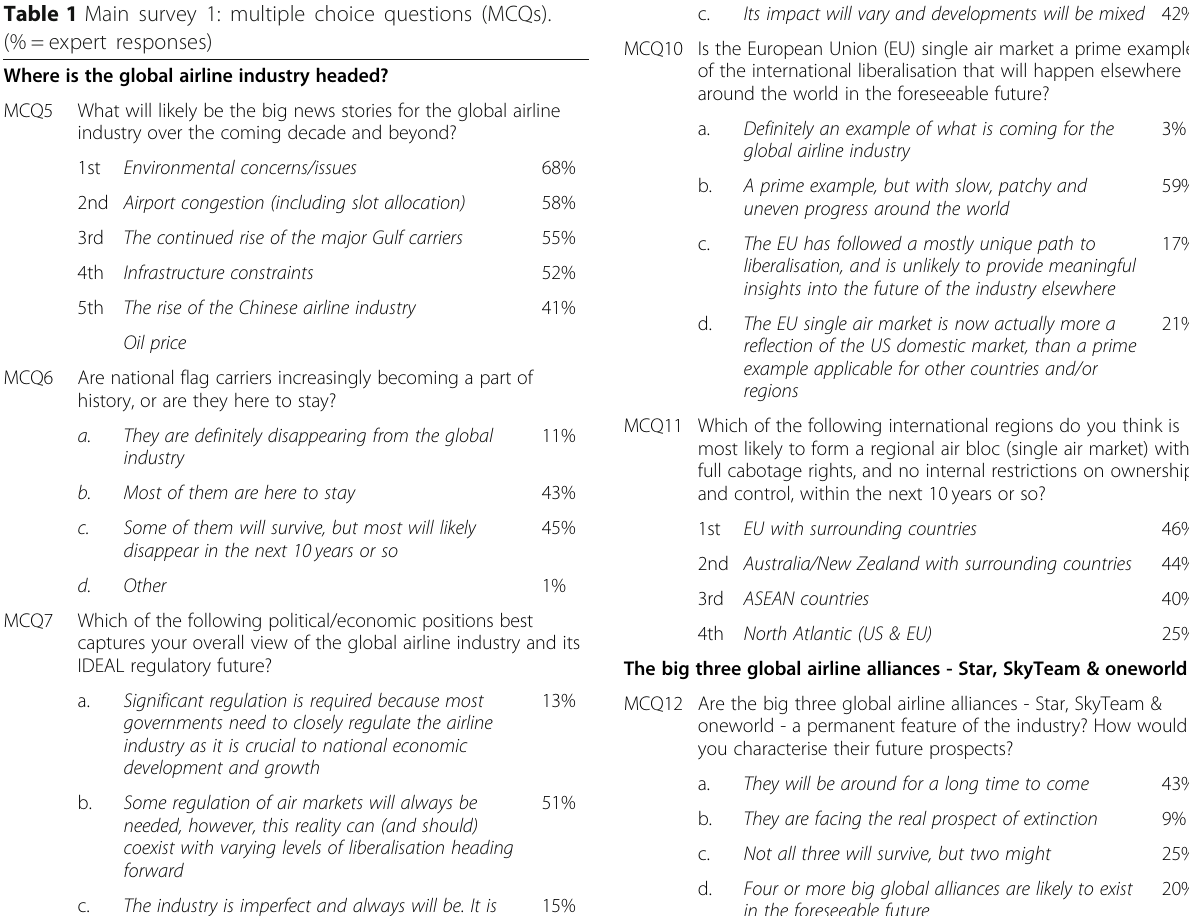
Table 1 Main survey 1: multiple choice questions